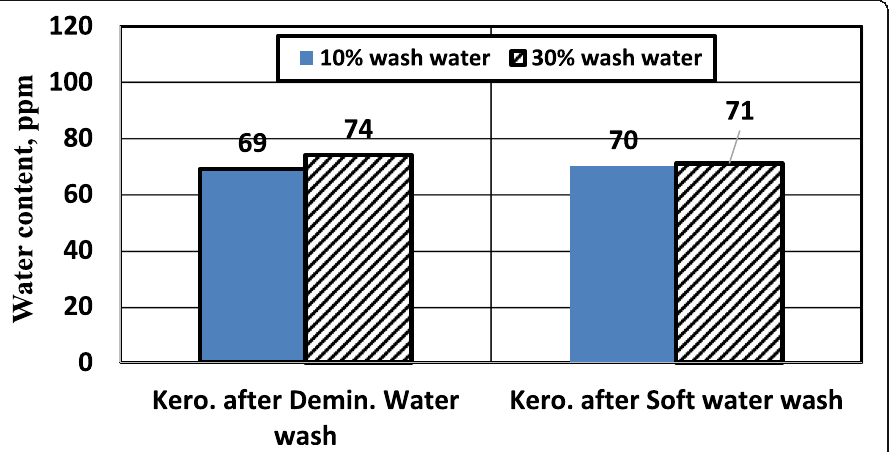
Fig. 6 Effect of wash water (type and volume) on the water content of treated